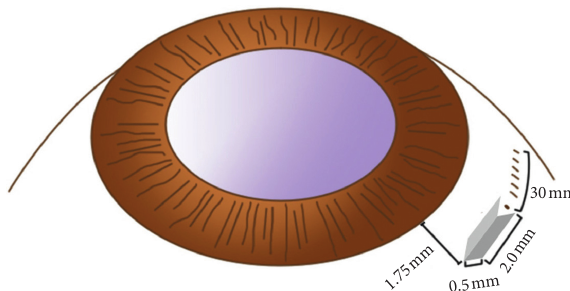
Figure 1: Diagram of position of scleral dissection.